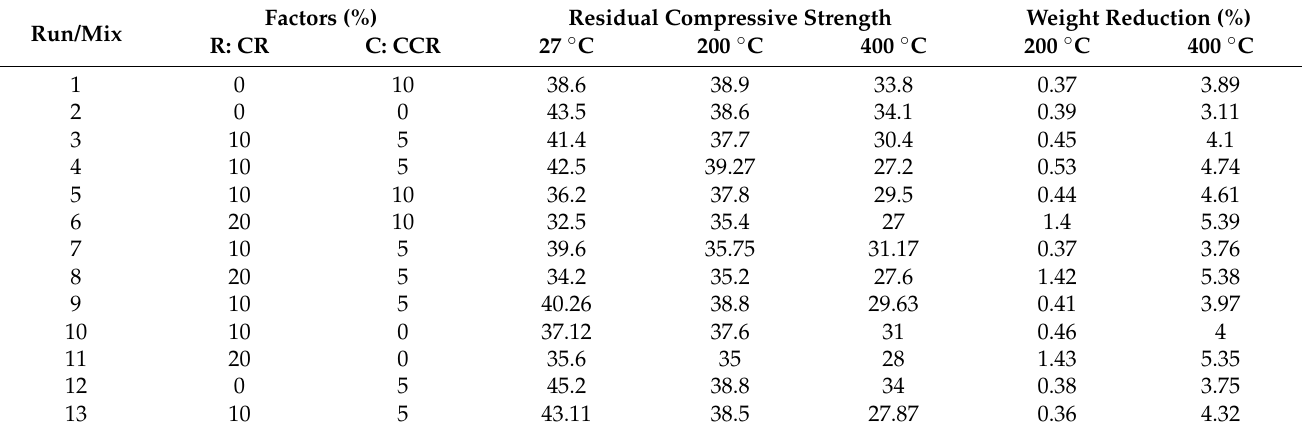
Table 6. Results for elevated temperatures of SCC